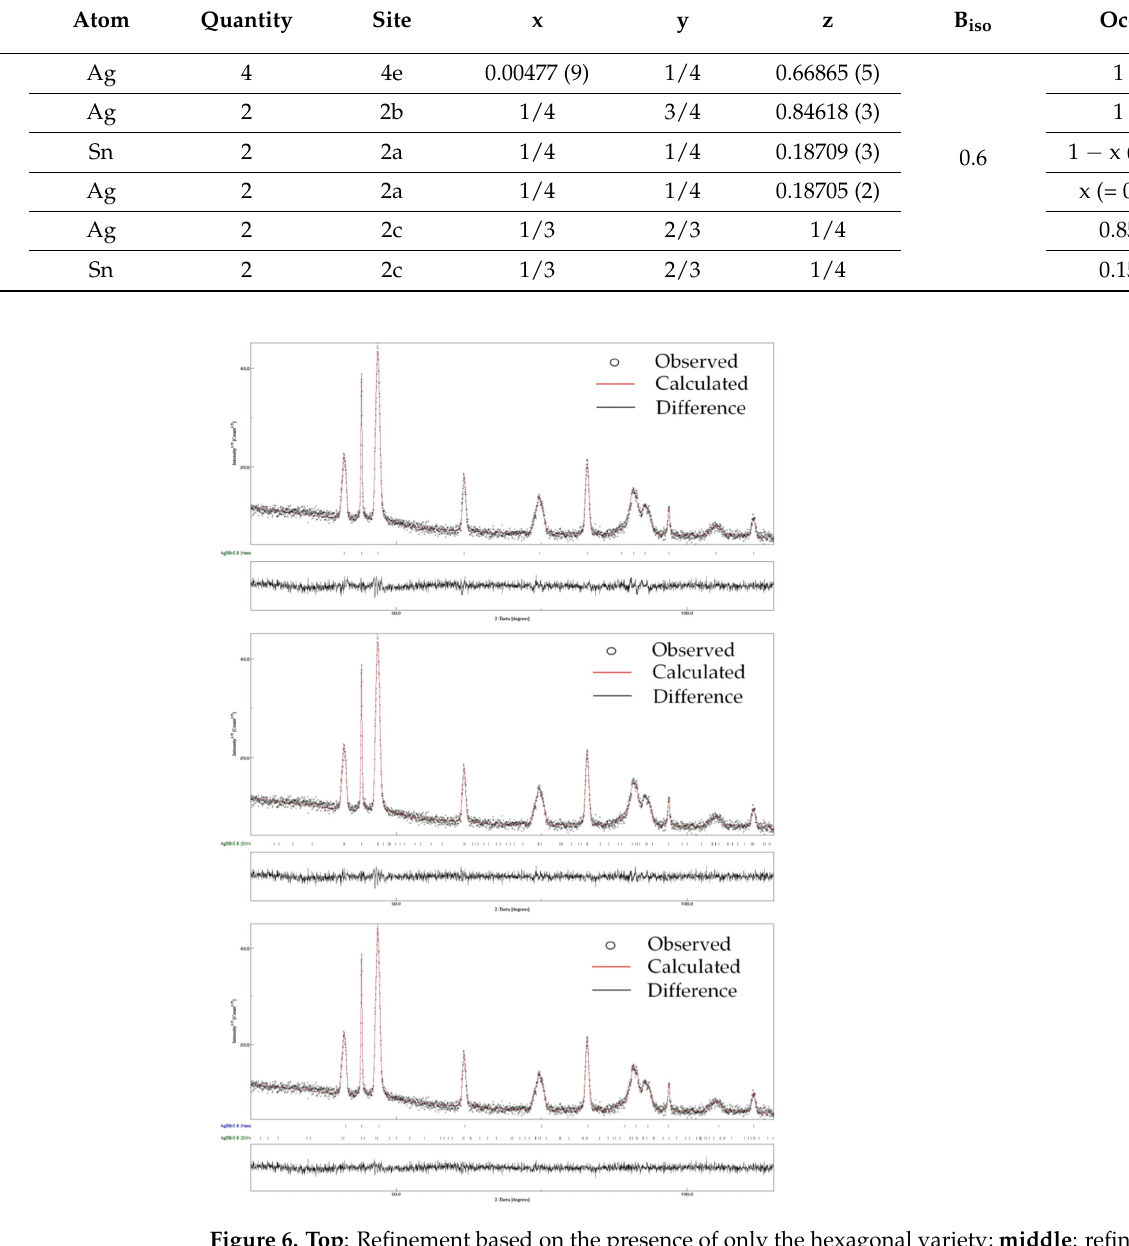
Table 3. Atomic positions in hypothesis (iii): presence of the two allotropic varieties.